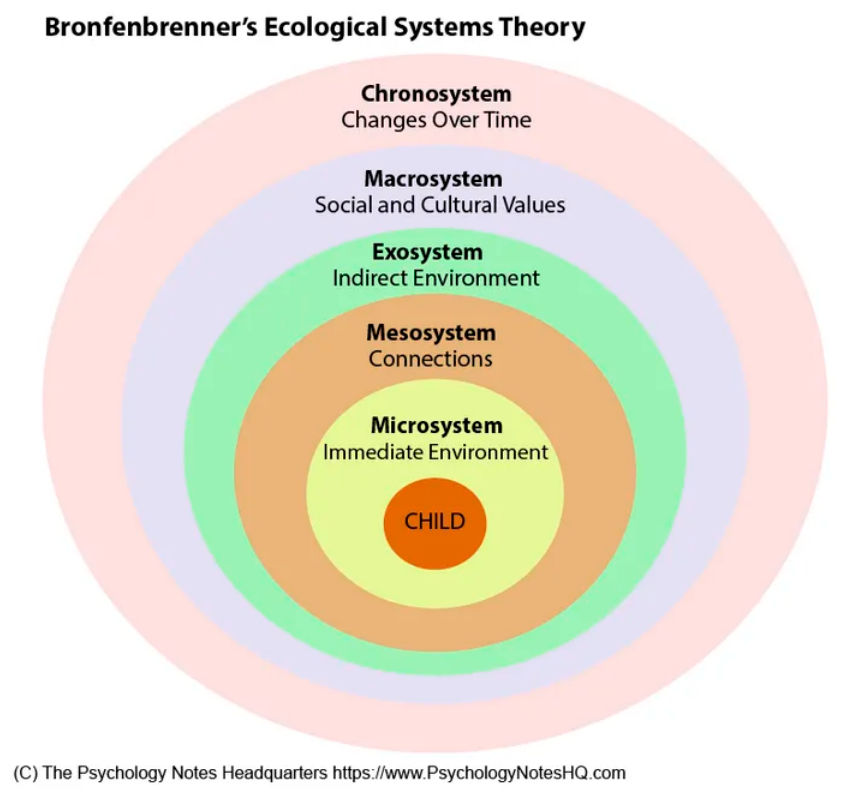
Figure 1. Bronfenbrenner’s Ecological Systems Model for Youth Development. Adapted with permission from Psychology Notes Headquarters [22].